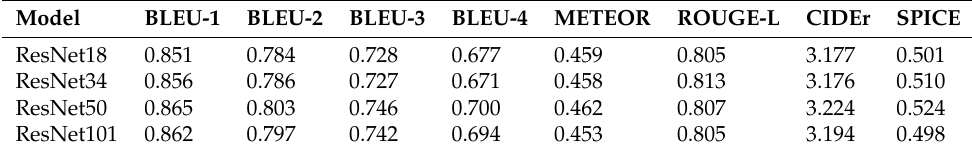
Table 6. Evaluation metrics results of DFEN with different ResNet in UCM-caption